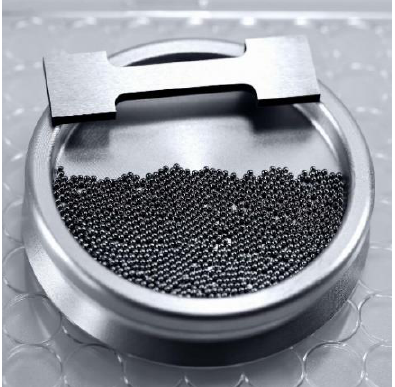
Figure 1. Quantity advantage: A total of 1315 microspheres with the same mass (5.37 g) as one flat tensile specimen (© Jan Rathke) [16].